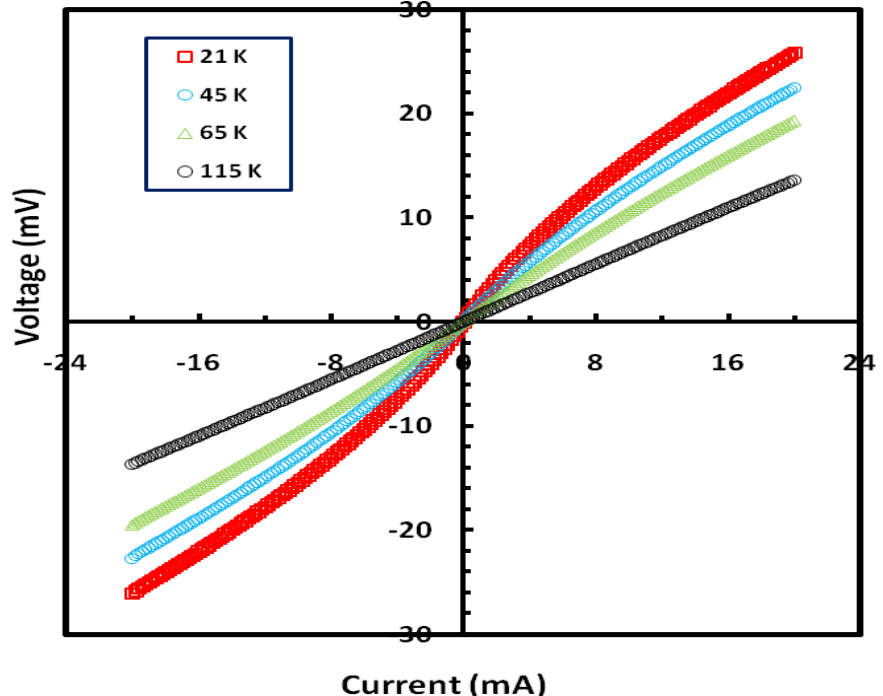
Figure 4. Current-Voltage (I-V) characteristics for a sample of Ni glass annealed at 973 K for one